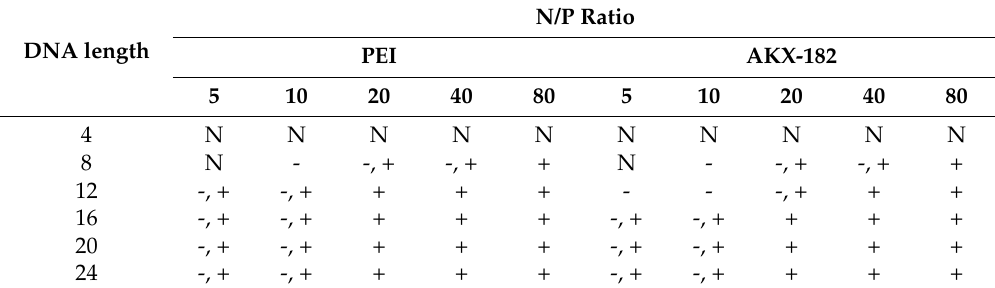
Table 3. Types of complexes observed in DNA–polymer interactions (pH = 7.4) 1 .